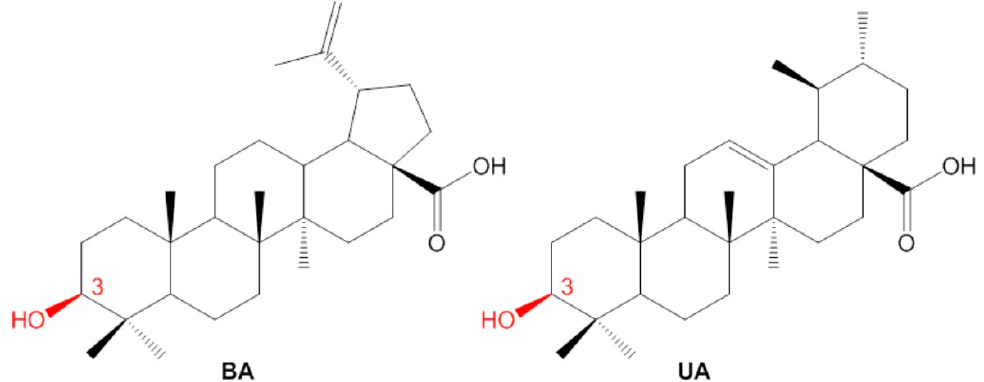
Figure 1. Chemical structure of betulinic acid (BA) and ursolic acid (UA).